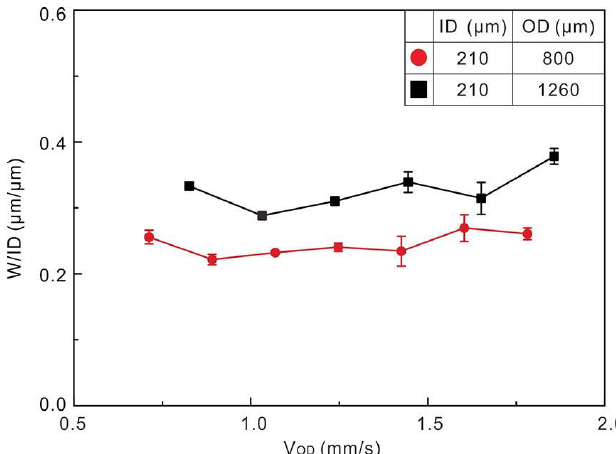
Figure 6. Trace widths normalized by ID as a function of outer channel flow speed. Two CNINE with different outer channel diameters were used (Q ID = 8 μL/min, V P = 40